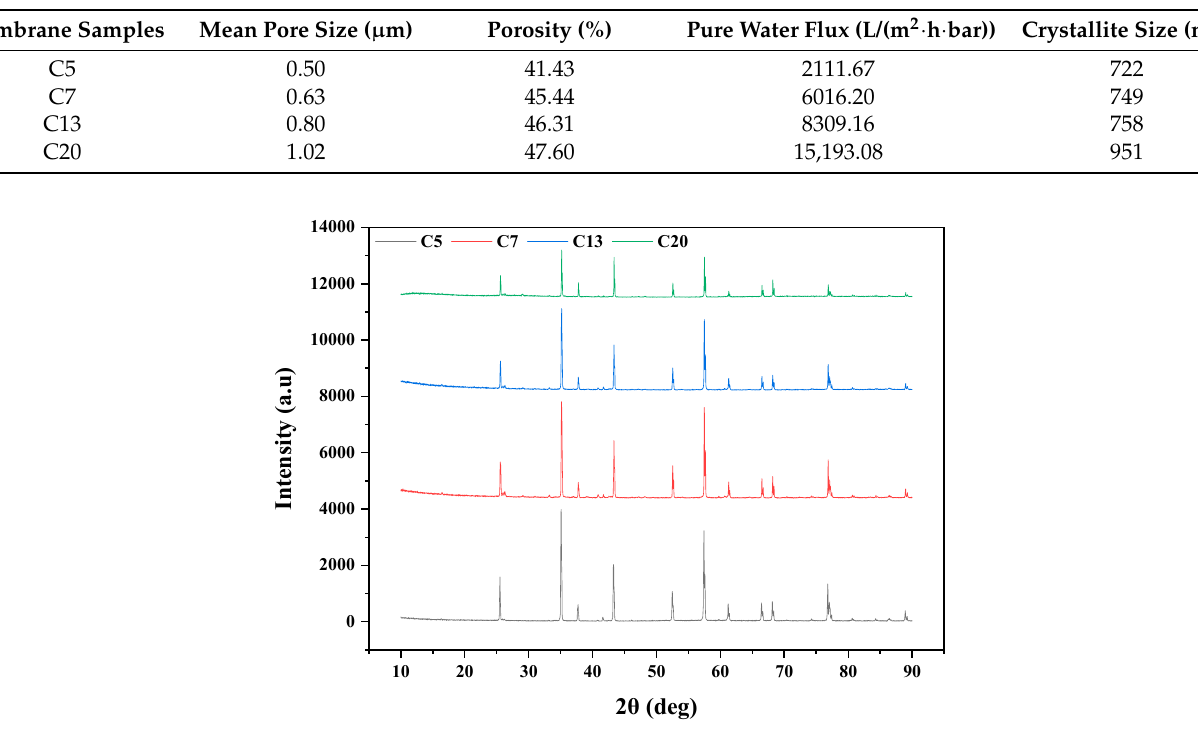
Figure 3. XRD of the ceramic membranes with different pore sizes.